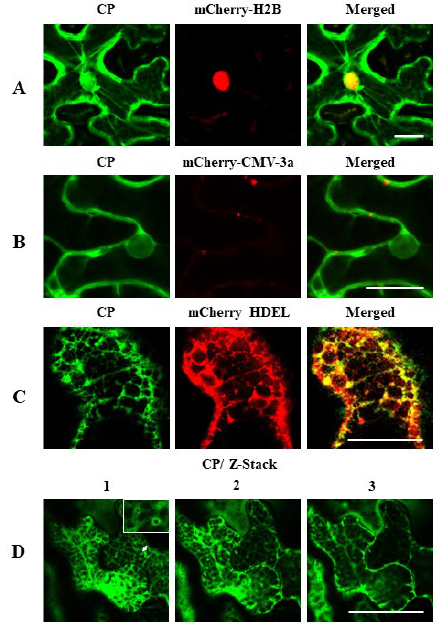
Figure 4. Subcellular location analyses of CYVCV coat protein (CP) in N. benthamiana epidermal cells. ( A ) Colocalization of CYVCV CP with marker protein mCherry-H2B at the nucleus. ( B ) CYVCV CP located at the nucleus and cell membrane but not colocalized with the PD marker protein mCherry-CMV-3a. ( C ) Colocalization of CYVCV CP with marker protein mCherry-HDEL at the ER. ( D ) Z-stack images of CYVCV CP in N. benthamiana epidermal cells captured at di ff erent layers (1–3). The vesicle-like structures developed from the ER are highlighted in the box (D1). Scale bars = 50 µm.